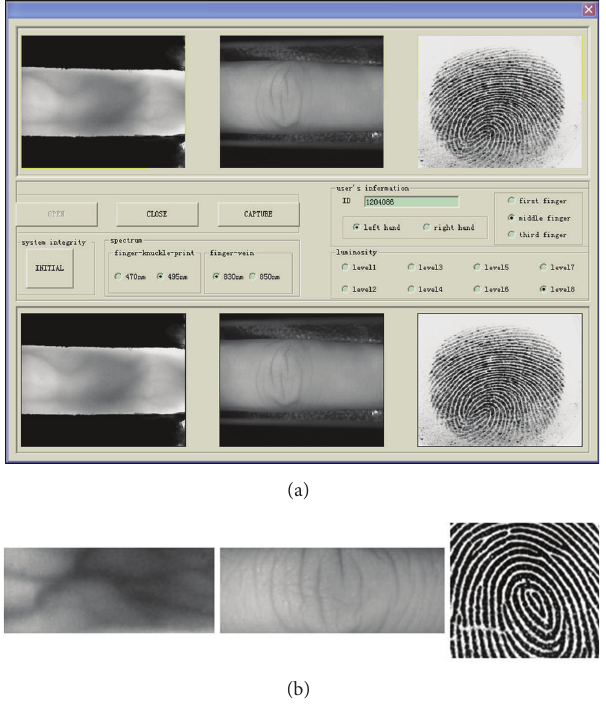
Figure 2: (a) A developed software interface of image acquisition. (b) The extracted ROI images (left: FV, middle: FKP, and right: FP).